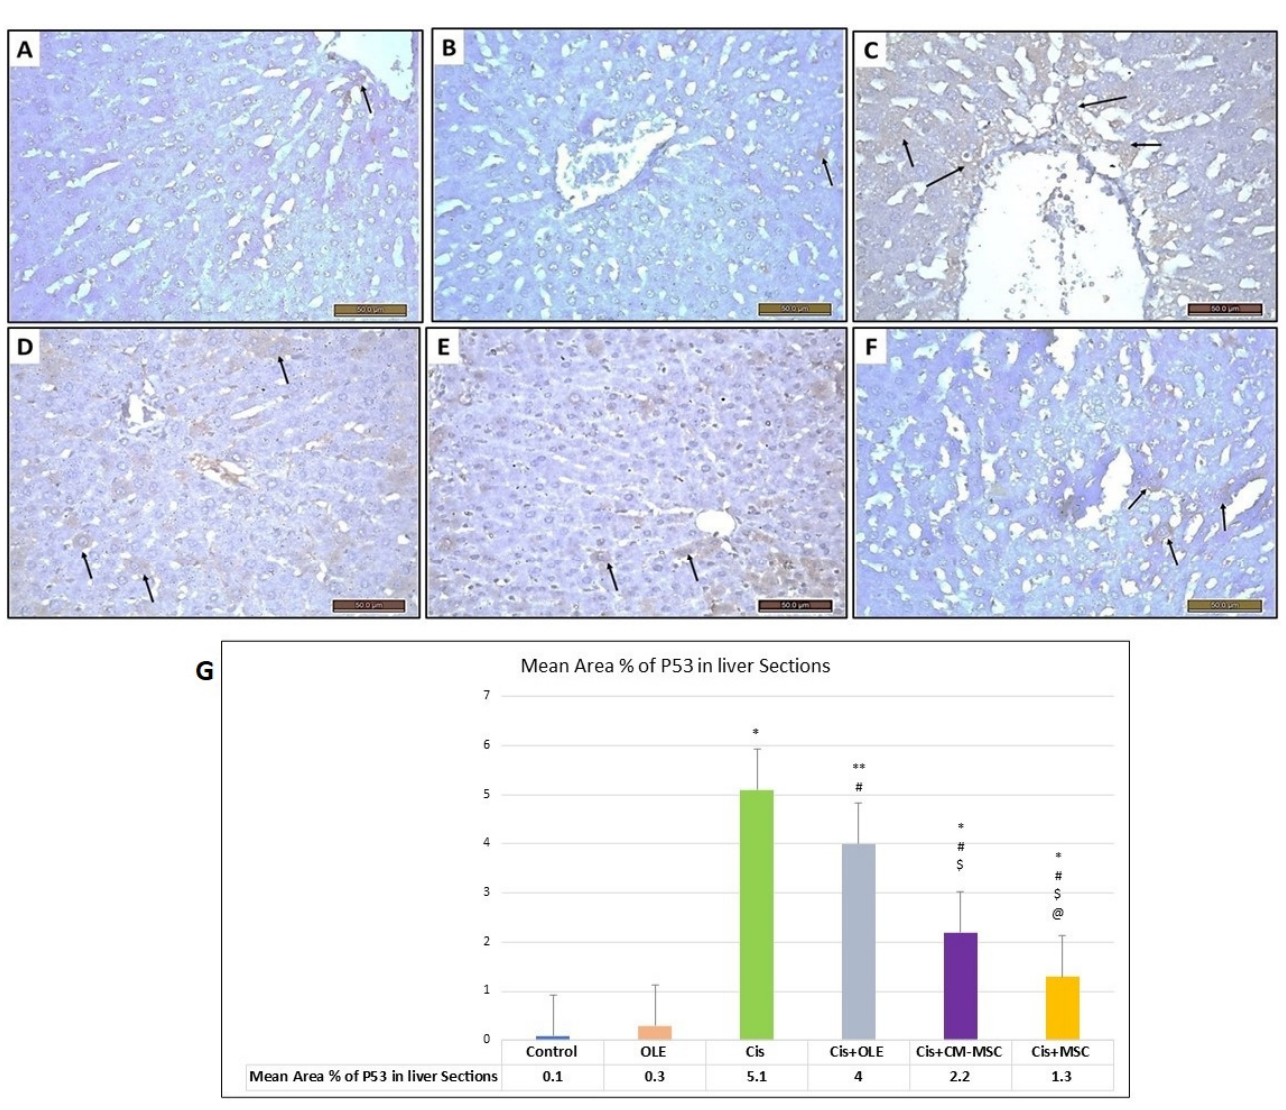
Figure 5. Photomicrographs of liver sections of all study groups immunohistochemically stained with anti P53 antibody. Control ( A ) and OLE ( B ) groups showed almost no expression of P53 antibody. While Cis group ( C ) showed apparent increase of its expression in some hepatocytes in comparison to Cis + OLE ( D ) and Cis + CM-MSC ( E ) groups. Minimal expression was observed in Cis + MSC group ( F ) (arrow). ( G ) The mean area percentage bar chart of P53 positively stained cells in the sections of the liver. Mean ± SEM was used to express the data of the experiment. 6 fields per section/rat. Significant in comparison to control group (*), Cis group (#), Cis + OLE group ($) and Cis + CM-MSC group (@); ( p < 0.05).